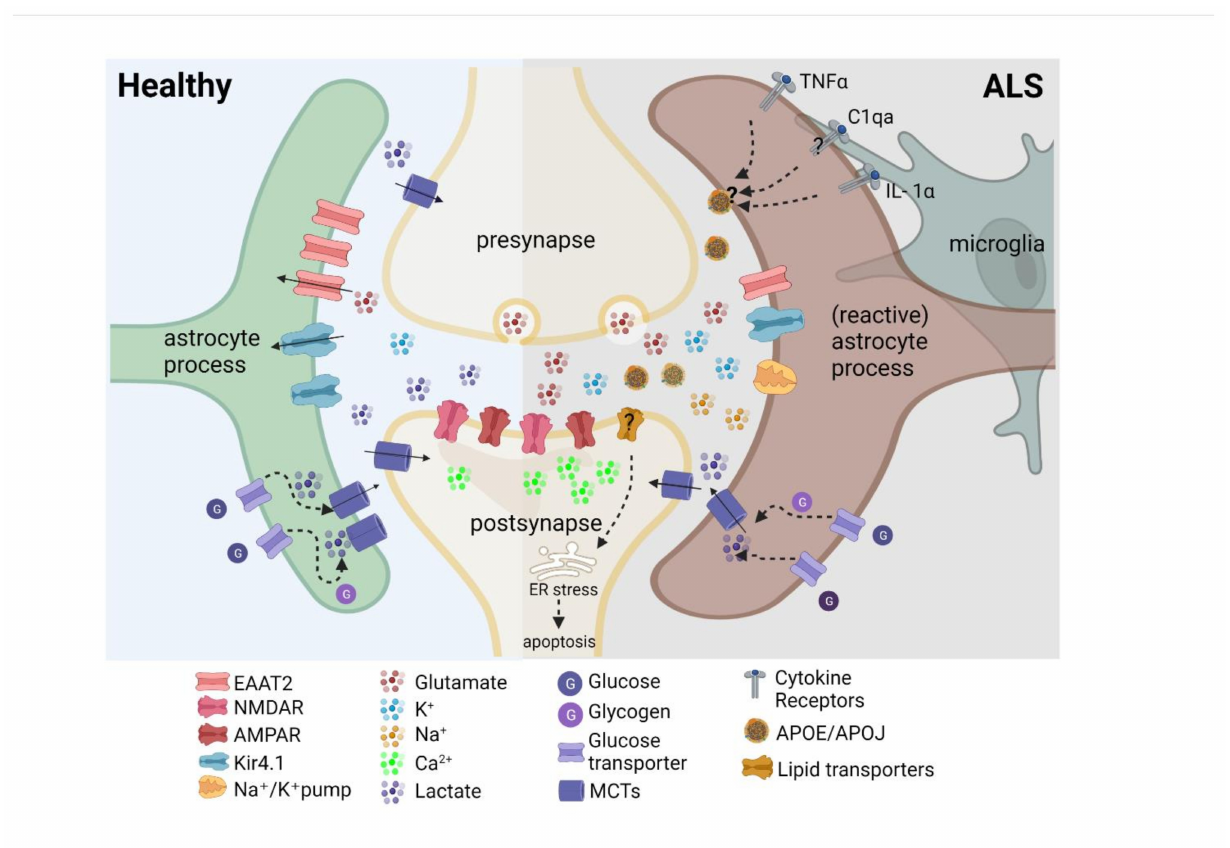
Figure 3. Altered molecular profile of astrocytes in ALS. The downregulation of astrocytic excitatory amino acid transporter 2 (EAAT2) could cause increased synaptic glutamate and postsynaptic α - amino-3-hydroxy-5-methyl-4-isoxazolepropionic acid receptor (AMPAR) and N-methyl-D-aspartate receptor (NMDAR) activation and increased Ca 2+ levels. Reduced expression of the inward rectifier potassium channel (Kir4.1) disrupts K + homeostasis, resulting in excess K + in the synaptic cleft. Reduced extracellular lactate levels might affect neuronal energy supply and alter activity levels and plasticity. Reactive astrocytes are induced by microglia secreting inflammatory cytokines interleukin 1 alpha (IL-1 α ), tumor necrosis factor (TNF- α ), and the complement component 1, subcomponent q (C1q)). Saturated lipids in apolipoprotein E (APOE), and apolipoprotein J (APOJ) lipoparticles were identified as the toxic factors secreted by reactive astrocytes, triggering